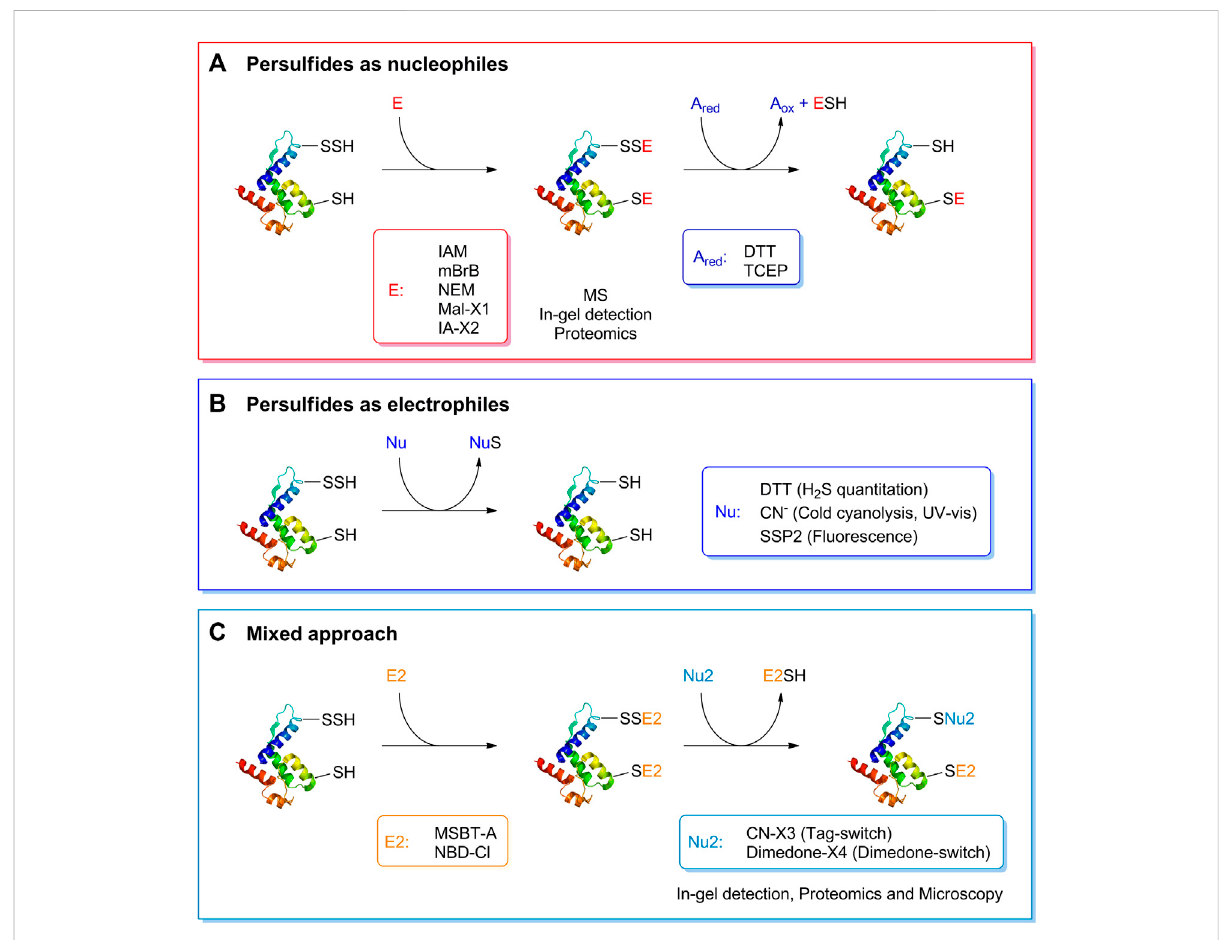
FIGURE 3 Detection of persul fi des based on their reactivity. (A) The nucleophilicity of persul fi des is exploited by means of the reaction with electrophilic alkylating agents such as iodoacetamide (IAM), monobromobimane (mBrB), N-ethylmaleimide and functionalized derivatives of maleimide and iodoacetamide(Mal-X1andIA-X2) togenerateamixeddisul fi de.Ontheotherhand, thiolsgenerateathioether.AsubsequentreductionwithDTTor TCEP generates the thiolfrom themixeddisul fi de. This strategy has been used to study theformation of persul fi des in LMW thiolsand proteins, combined with mass spectrometry detection, in-gel detection or proteomics approaches. (B) The electrophilicity of persul fi des is used when detecting persul fi des by DTT reduction and H 2 S quanti fi cation, in the cold cyanolysis method detecting the ultimate formation of ferric thiocyanate, and with the fl uorogenic probe SSP2. (C) A mixed approach has also been devised that fi rst uses electrophilic reagents such as MSBT-A or NBD-Cl that generate an activated disul fi de. In a second step, a nucleophile, either a functionalized cyanoacetate derivative or dimedone derivative, speci fi cally reacts with this activated disul fi de that then labels the site covalently. These methods have been named Tag-switch and dimedone- switch, respectively, and have been used in combination with in-gel detection, fl uorescence microscopy and proteomics approaches. Further information is provided in the text and in (Cuevasanta et al.,